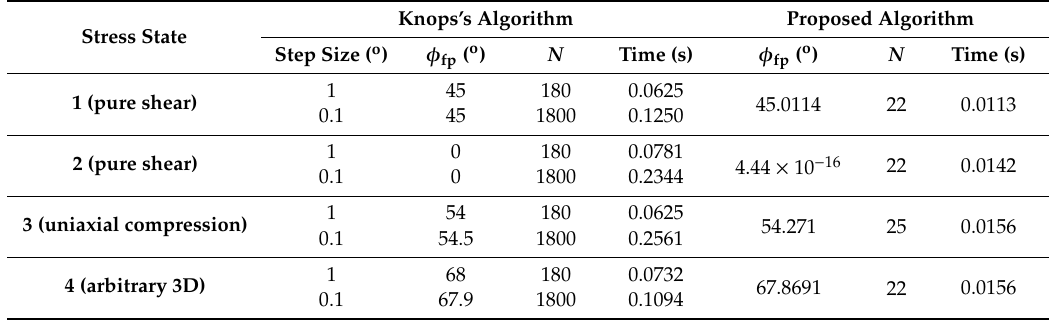
Table 2. Comparison of the e ffi ciency and accuracy of the proposed algorithm with those of Knops’ algorithm.